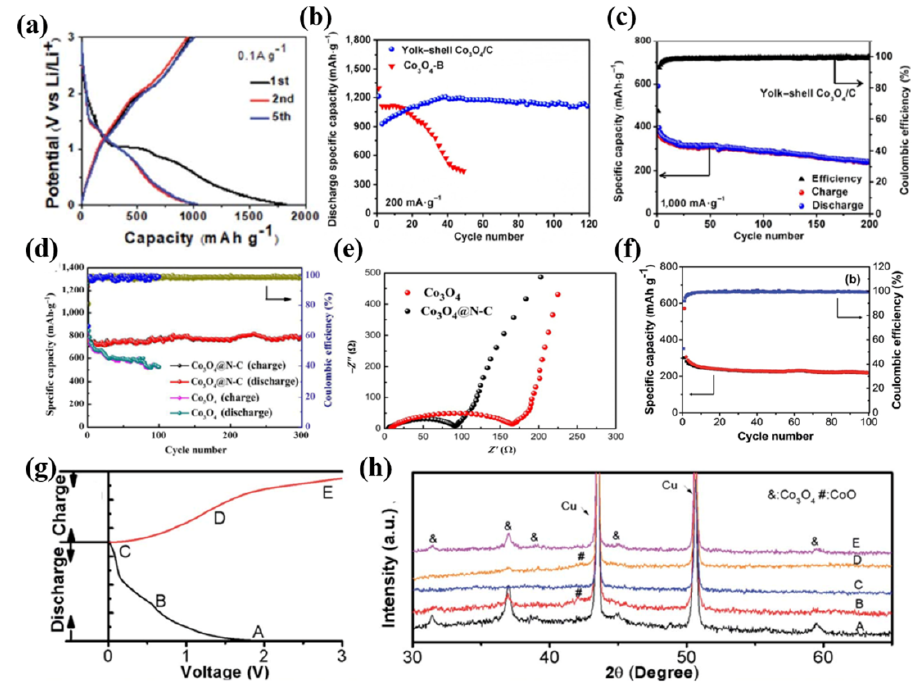
Figure 10. Electrochemical performances of cobalt-based anode materials. ( a ) Galvanostatic discharge-charge profiles of ES-CNCo 3 O 4 at 0.1 A g − 1 [11]. ( b ) Cycling performance of the yolk-shell Co 3 O 4 and Co 3 O 4 -B at 0.2 A g − 1 for LIBs. ( c ) Cycling properties of the yolk-shell Co 3 O 4 at 1 A g − 1 for SIBs [129]. ( d ) Cycling performance of Co 3 O 4 and Co 3 O 4 @N-C at 0.5 A g − 1 . ( e ) Electrochemical impedance spectra for Co 3 O 4 and Co 3 O 4 @N-C [128]. ( f ) Cycling performance of the Ni-doped Co/CoO/NC electrode and the corresponding columbic efficiencies at 0.5 A g − 1 [126]. ( g ) Galvanostatic charge-discharge profiles. Points A, B, C, D and E represent the pristine state, the discharge state at 0.6 V and 0.01 V and the charged state at 1.4 V and 3 V, respectively. ( h ) Ex-situ XRD patterns corresponding to these points